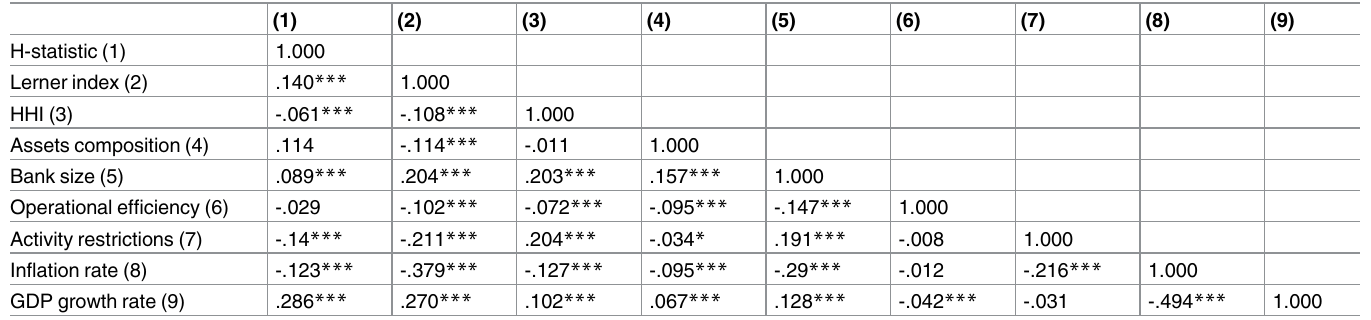
Table 3. Pearson pair wise correlation matrix of independent variables used in the analysis.